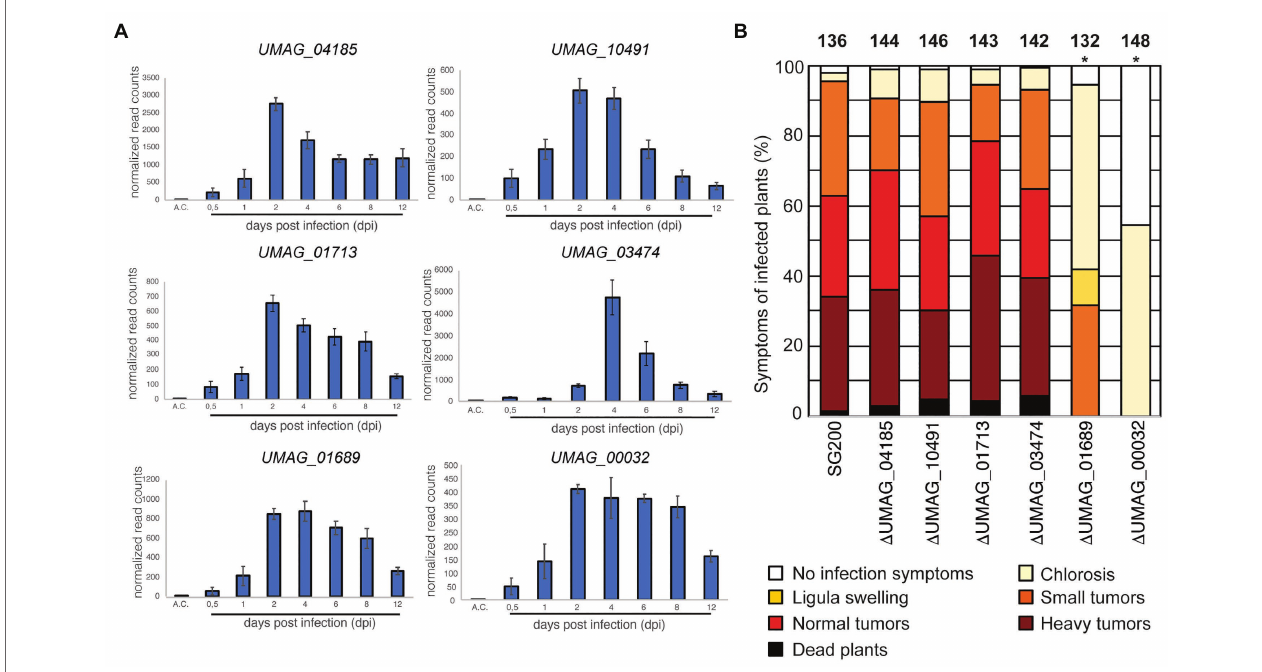
FIGURE 1 | Identification of a transmembrane protein important for virulence (A) The expression pattern of genes encoding transmembrane proteins in Ustilago maydis during plant infection re-analyzed from RNA sequencing data (Lanver et al., 2018). A.C., expression level in axenic culture. The numbers below the bars indicate the days post inoculation (dpi). Error bars indicate ±standard deviation. (B) Virulence assay of genes encoding transmembrane proteins in the U. maydis SG200 background. Disease symptoms were quantified on maize leaves 12 days post infection (dpi). Similar results were observed in three independent experiments. Shown is the mean percentage of plants placed in a particular disease category. The number of infected plants is indicated above the bars. The asterisk indicates a significant difference in infection symptoms between SG200, SG200ΔUMAG_00032, and